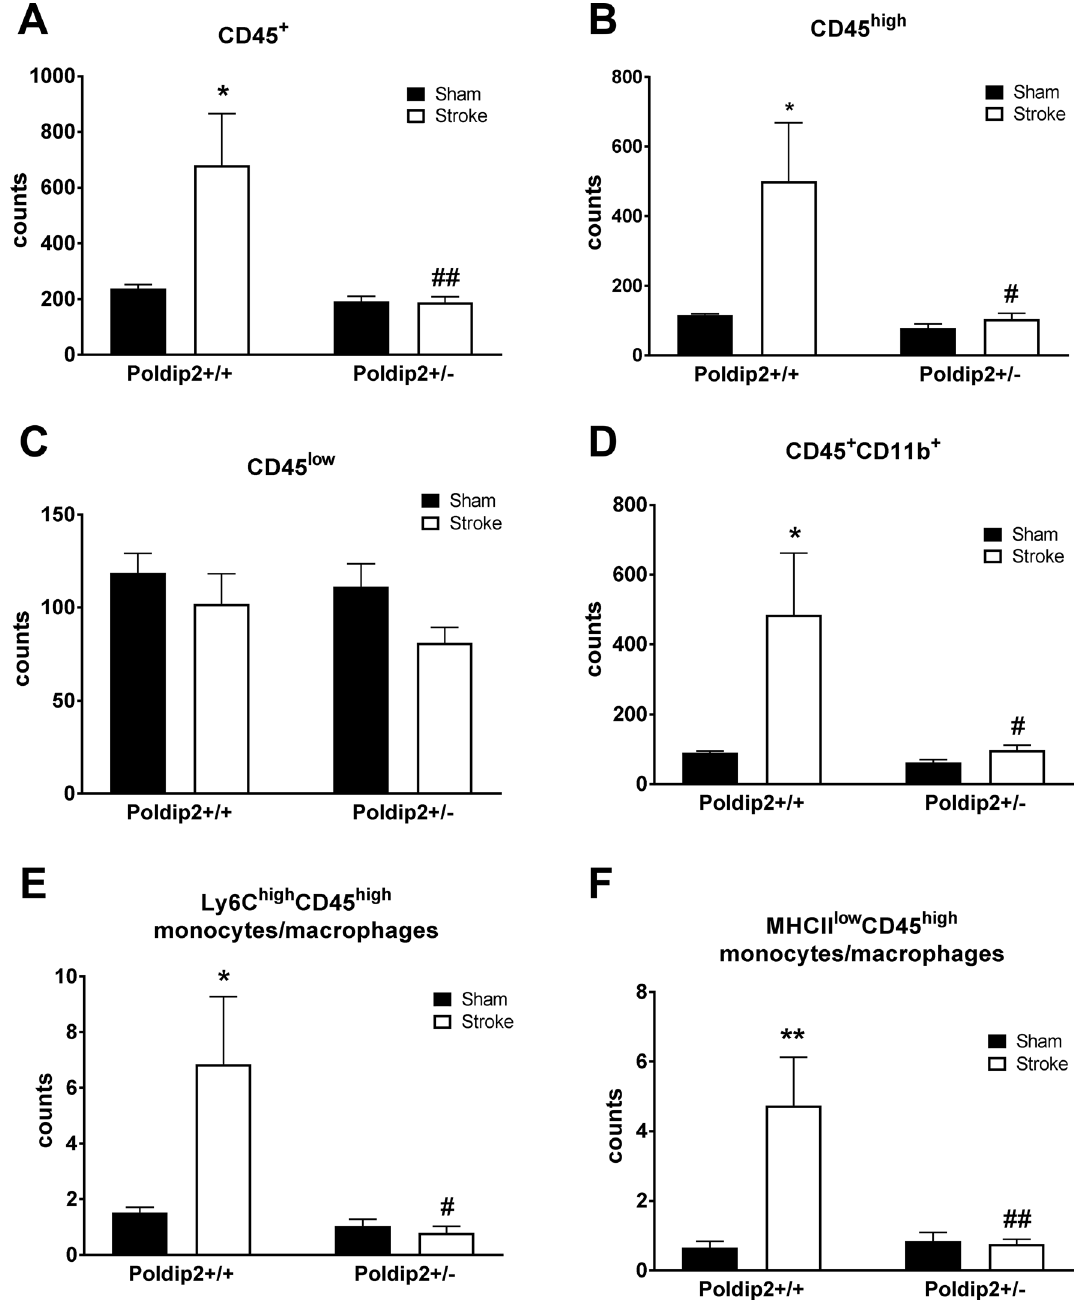
Figure 1. Poldip2 regulates the recruitment of leukocytes following cerebral ischemia induction. (A–F) Major brain immune subsets were characterized using quantitative multi-colored flow cytometry 48 h after sham surgery or hypoxia-induced permanent stroke in Poldip2 +/+ and +/− mice. Bar graphs represent means ± SEM counts from 6–8 mice per group adjusted using counting beads. Two-way ANOVA *P < 0.05, **P < 0.01 vs. Poldip2 +/+ sham mice, and # P < 0.05, ## P < 0.01 vs. Poldip2 +/+ ischemic Poldip2 silencing blocks TNF‑ induced FAK phosphorylation. TNF induces VCAM-1 expression via several intracellular signaling pathways, which include MAPK, AP-1 and NF-κB 32 . Additionally, FAK signal- ing has been previously shown to facilitate TNF-induced VCAM-1 expression in HUVECs 19 . We have previ- ously reported that Poldip2 regulates FAK activation in smooth muscle cells 20 . To first determine whether TNF induces FAK activation in RBMECs, cells were stimulated with TNF (10 ng/ml) for either 30 min, 1.5, 3 and 6 h and FAK phosphorylation on Y397 (FAKpY397) was assessed by western blotting assay. While total FAK protein levels remained unchanged, FAK phosphorylation was increased in response to 6 h of TNF treatment (Fig. 4A).